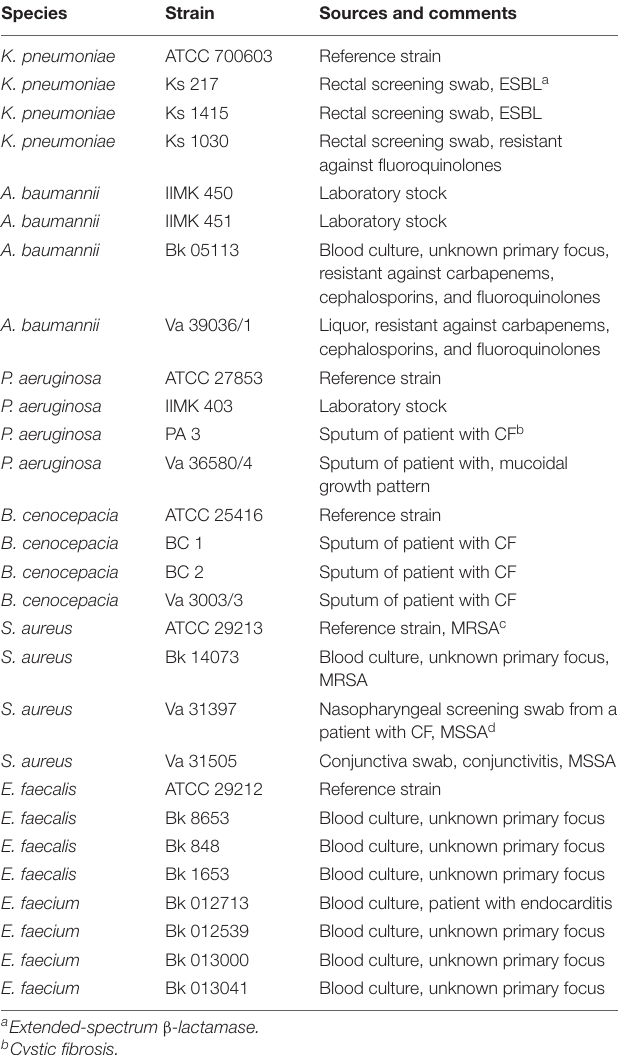
TABLE 1 | Bacterial strains used in this